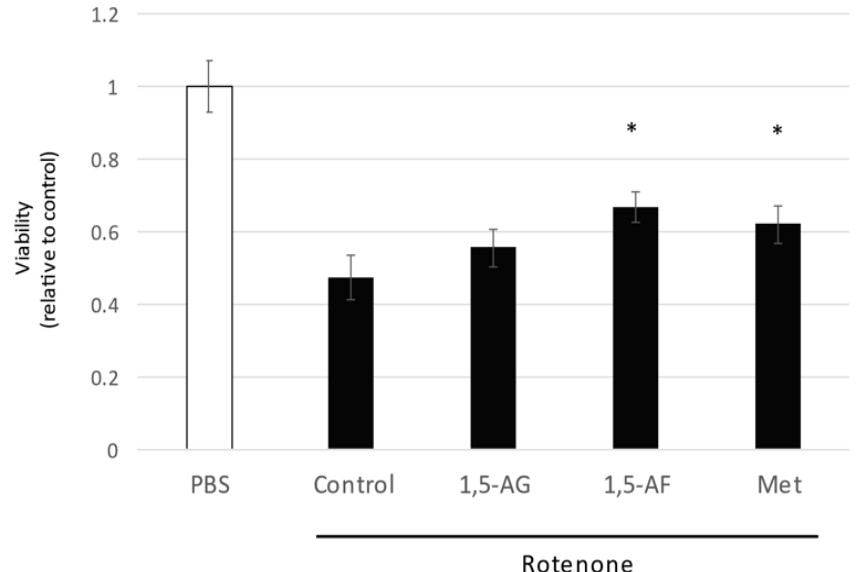
Figure 4. Effects of 1,5-AF, 1,5-AG, and metformin on rotenone-induced cytotoxicity in PC12 cells. Both 1,5-AF and metformin, but not 1,5-AG, had protective effects against rotenone-induced cytotoxicity, evaluated using the MTT assay (one-way analysis of variance followed by Dunnett’s test). Data are expressed as the mean ± standard error of the mean of quadruplicate pooled experiments ( n = 8 for the Control, PBS, and 1,5-AF conditions; n = 4 for the Met and 1,5-AG conditions). * p < 0.05. 1,5-AF, 1,5-anhydro-D-fructose; 1,5-AG, 1,5-anhydroglucitol; Met, metformin; PBS, phosphate-buffered saline; Rot, rotenone.